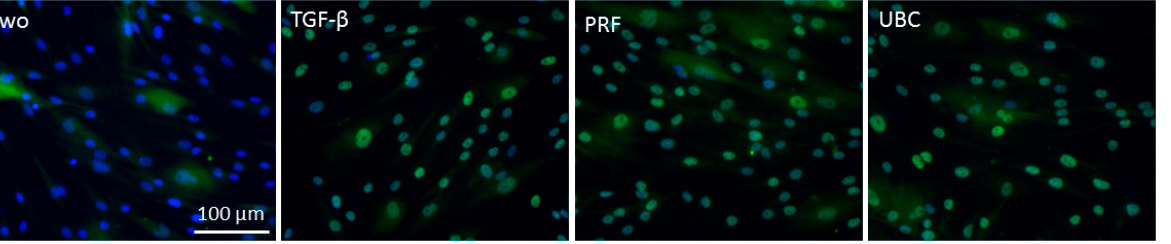
Figure 4 . PRF lysate activated the translocation of Smad2/3 from the cytoplasm into the nucleus . Gingival fibroblasts were exposed to TGF- β as a positive control and PRF and UBC lysates. Immu- nofluorescence analysis of the nuclear translocation of Smad2/3 is shown. The blue dots represent nuclei which is hidden by the green dots representing antibody-positive nuclei; “wo” indicates without and represents unstimulated cells. Microscopic magnificence was set at 20 ×